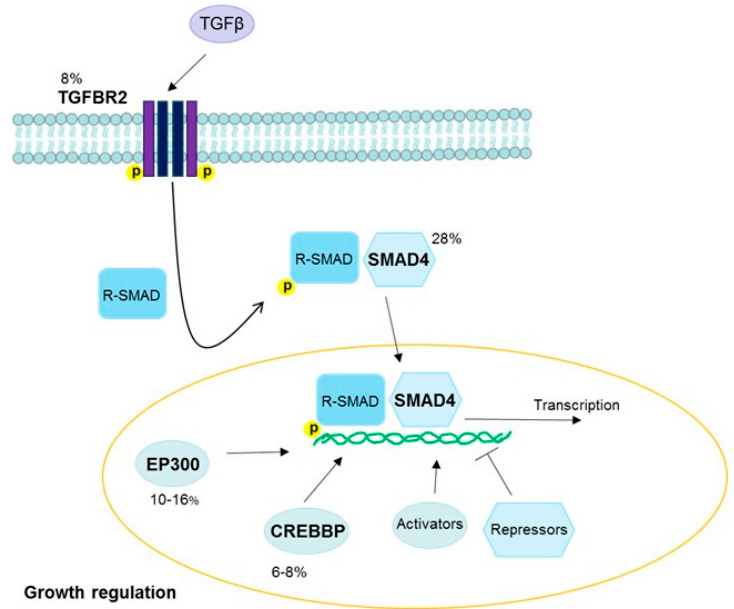
Figure 6. TGF β pathway. TGF β binds to TGFBR2 and other receptors to form a complex which becomes phosphorylated. This triggers the phosphorylation of R-SMADs. The phosphorylated R-SMADs form a complex with SMAD4 and are transported into the nucleus, where they promote transcription by binding to promotor regions of the DNA. EP300 and CREBBP are two activators commonly mutated in HPV-driven cancers, and many other activators and repressors also act to regulate this pathway. Fractions of cervical cancers with each gene mutated are noted [18]. Abbreviations: TGF β , transforming growth factor beta; TGFBR2, TGF β receptor 2; R-SMAD, receptor-regulated SMAD; EP300, E1A binding protein p300; CREBBP, CREB binding